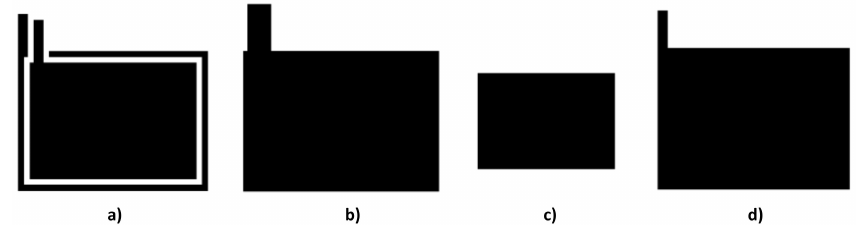
Figure A1. ELD Design: Conductive silver electrode ( a ); dielectric layer ( b ); Phosphor layer ( c ); and clear conductor ( d ).